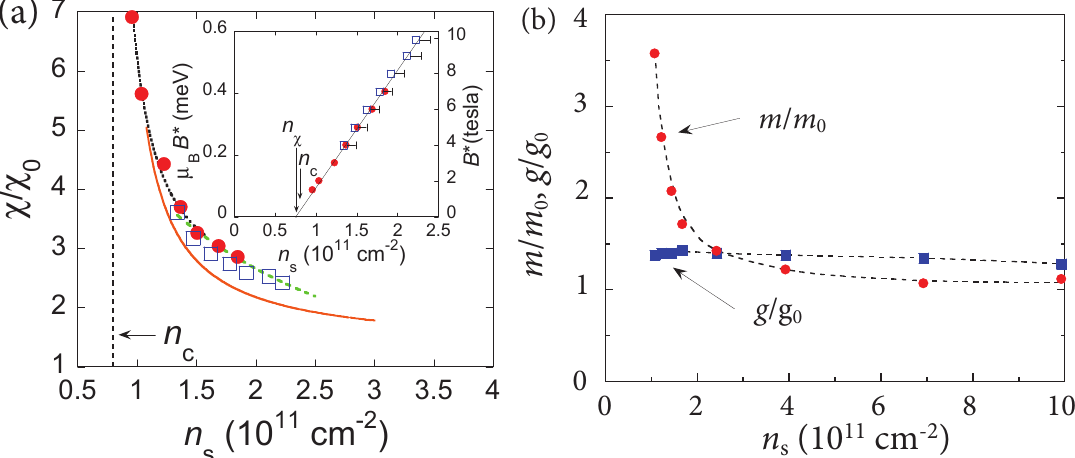
Figure 4. ( a ) Dependence of the Pauli spin susceptibility on electron density in a silicon MOSFET obtained by three independent methods: thermodynamic measurements of the magnetization (dashed line), the magnetic field of the full spin polarization (circles), and magnetocapacitance (squares). The dotted line is a guide to the eye. Also shown by a solid line are the transport data of [29]. The inset shows the polarization field as a function of the electron density determined from the magnetization (circles) and magnetocapacitance (squares) data. The symbol size for the magnetization data reflects the experimental uncertainty. The dependence extrapolates linearly to zero field at a density n χ just below n c . Adapted from [30]. ( b ) The effective electron mass m (circles) and g -factor (squares) in a silicon MOSFET, determined from the analysis of the parallel field magnetoresistance and temperature-dependent conductivity, versus electron density. m 0 and g 0 are the electron mass and g -factor for non-interacting electrons in silicon. The dashed lines are guides to the eye. Adapted from